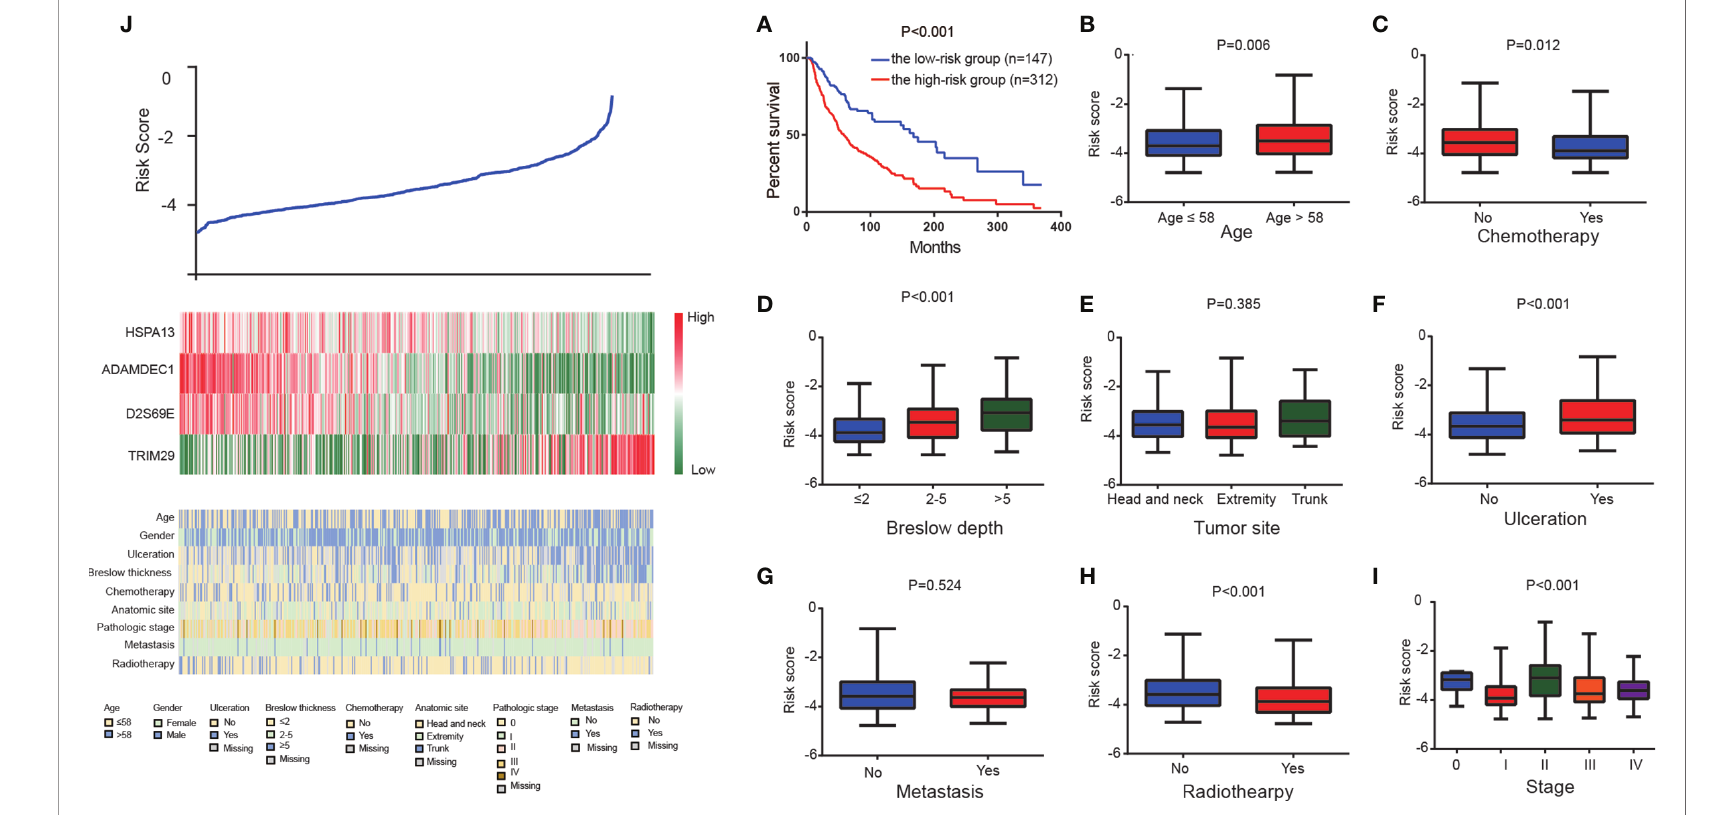
FIGURE 3 | The four-gene signature-derived risk score. (A) Kaplan – Meier overall survival analysis among TCGA CM patients strati fi ed by risk score. Association between the risk model and different clinical characteristics. (B) Age. (C) Chemotherapy. (D) Breslow depth. (E) Tumor site. (F) Ulceration. (G) Metastasis. (H) Radiotherapy. (I) Stage. (J) The value of risk score (top), The corresponding expression of four genes (middle), and the associated clinicopathological parameters